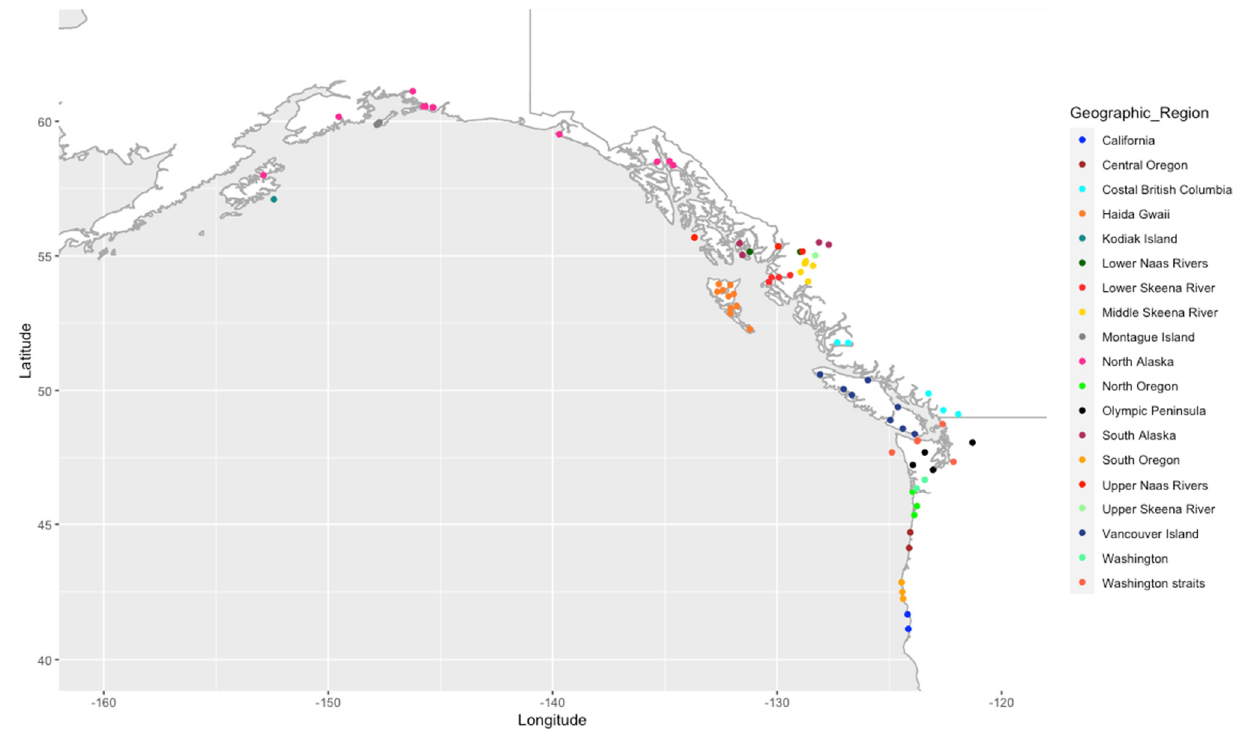
Figure 1. Origins of Sitka in the IUFRO population. The main population in the database is the IUFRO population, which consists of trees planted from seed collected in locations marked.